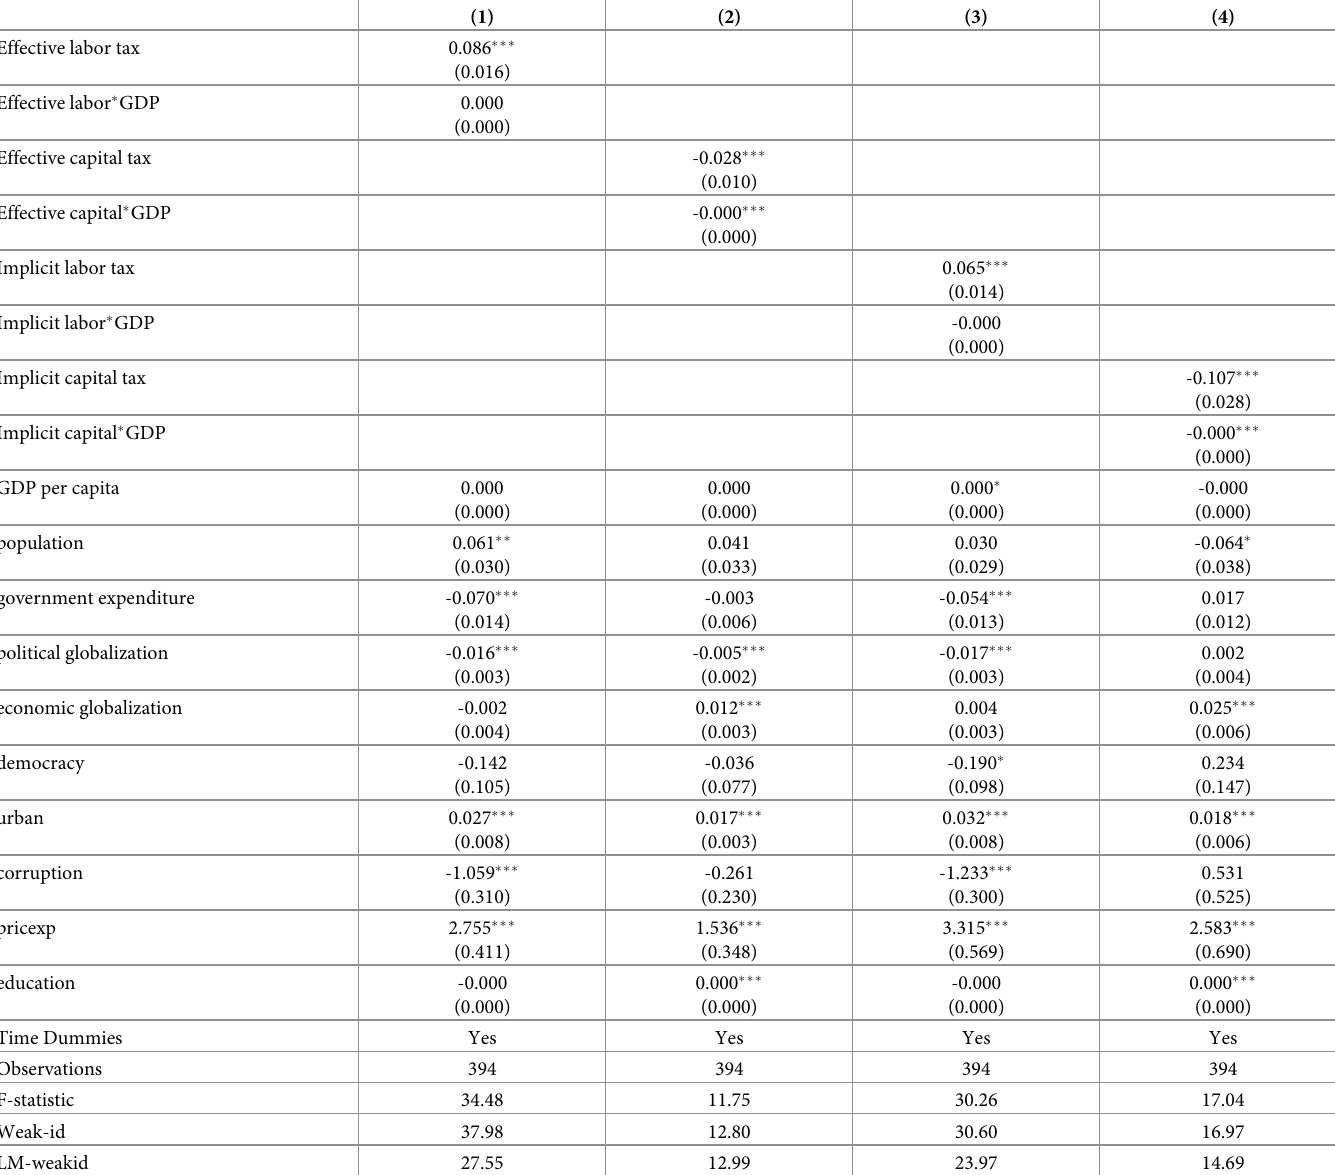
Table 10. The impact of economic development on the nexus between taxation and economic